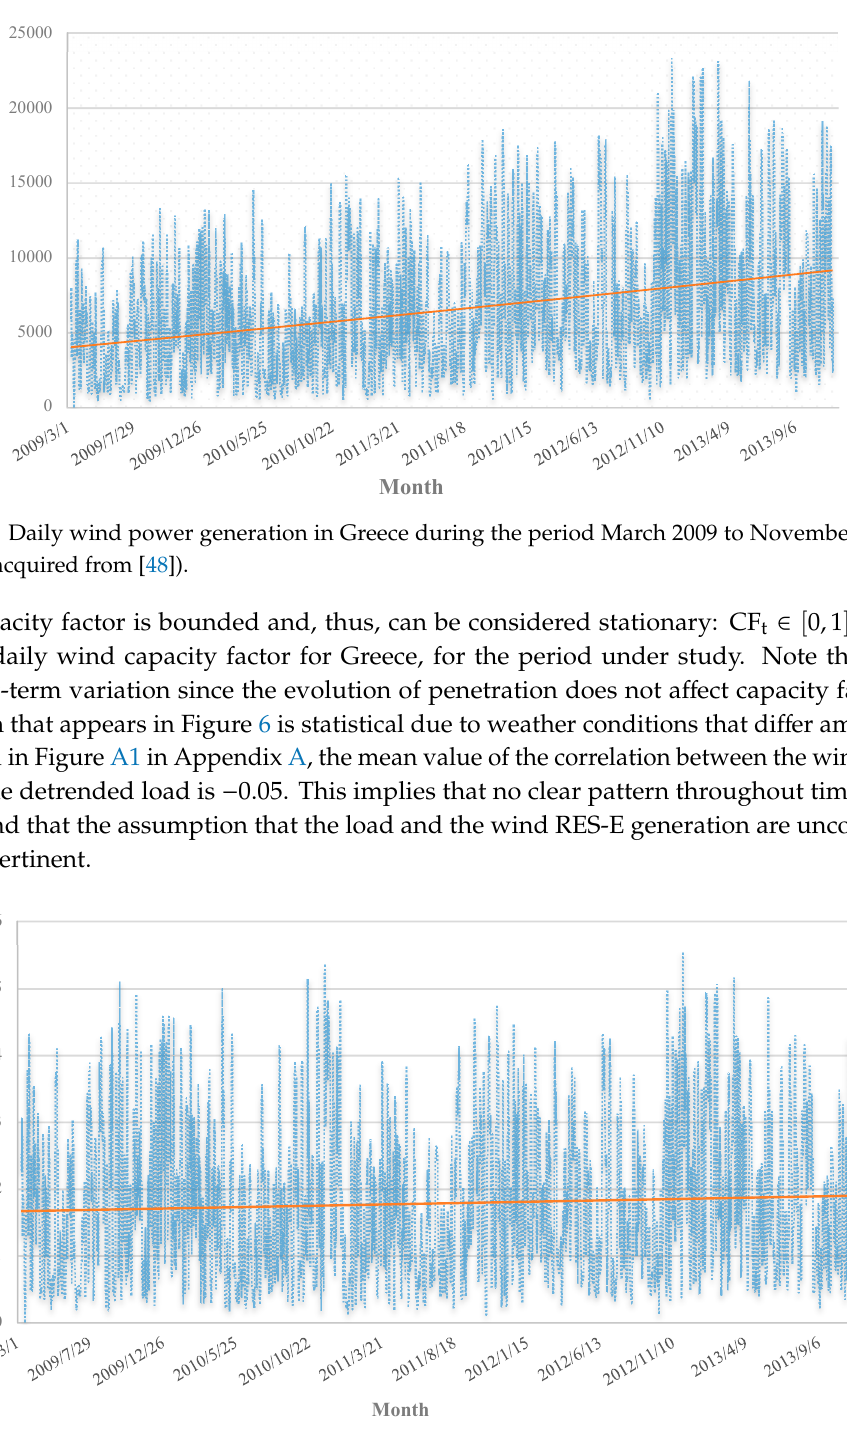
Figure 6. Daily wind capacity factor in Greece during the period March 2009 to November 2013 (data as acquired from [48]).